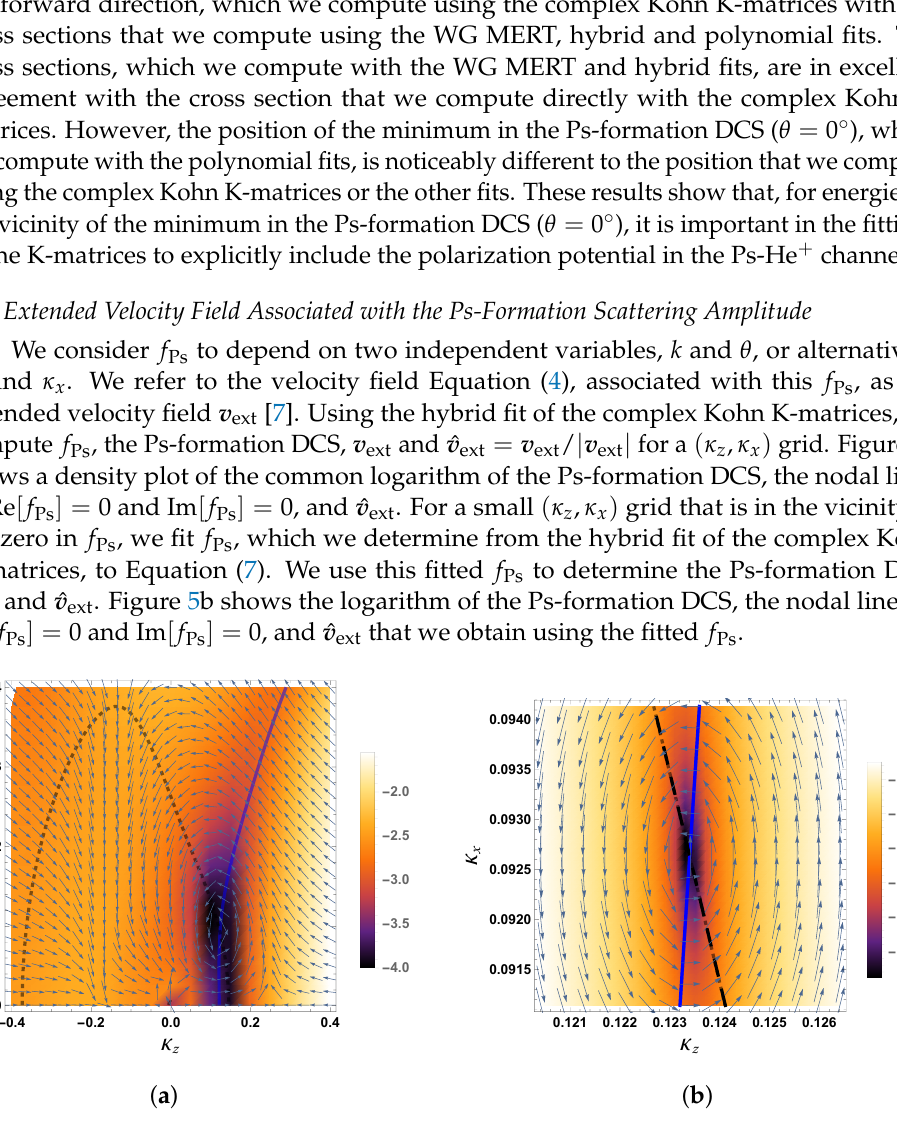
[ DCS ] for Ps-formation in positron–helium collisions. The nodal Figure 5. The density plot of log 10 lines of Re [ f Ps ] = 0 and Im [ f Ps ] = 0 are denoted by the solid blue line and the dashed black line, respectively, while ˆ v ext is represented by the arrows. ( a ) We use the hybrid fit to compute f Ps , the Ps-formation DCS and ˆ v ext . ( b ) A small ( κ z , κ x ) grid that is in the vicinity of the zero in f Ps . We use Equation (7) to fit f Ps that we compute using the hybrid fit, and we use the fitted f Ps to compute the Ps-formation DCS and ˆ v ext